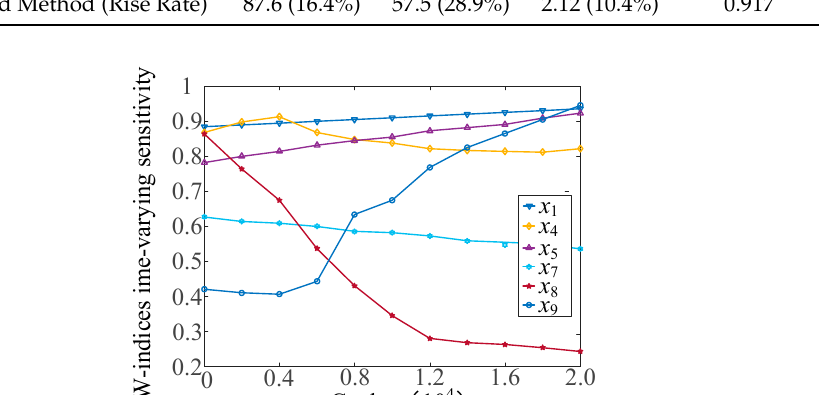
Figure 9. Random error comparison.